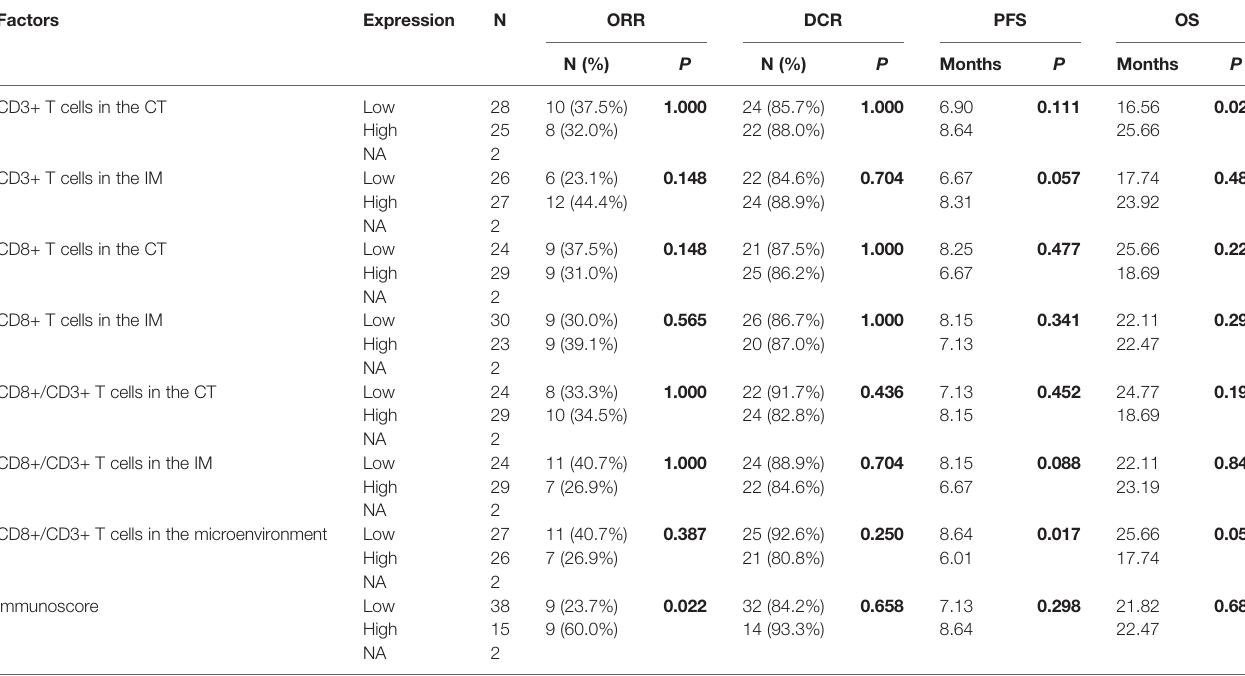
Bold values indicate P < 0.05; CT, Core of the tumor; DCR, Disease control rate; IM, Invasive margin; PFS, Progression-free survival; NA, Not applicable; ORR, Overall response rate; OS, Overall survival.